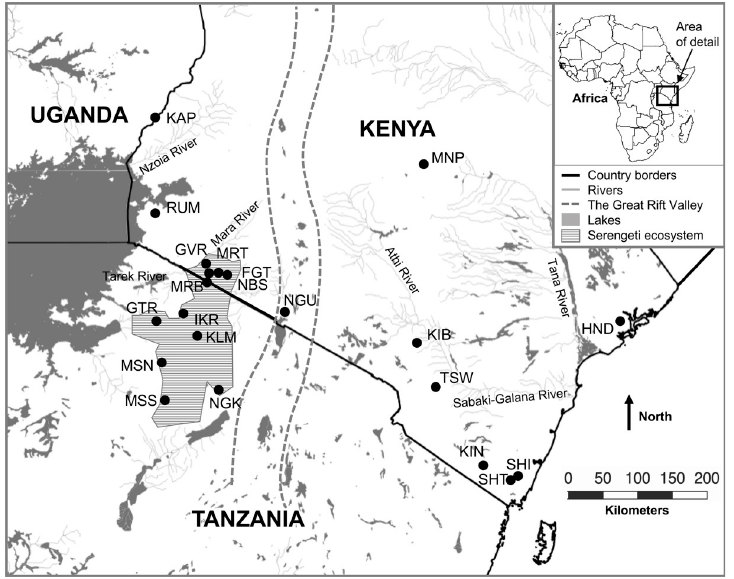
Fig 1. Map showing sample sites in Kenya and Tanzania and location of the study region within Africa. Sampling sites shown with dots and labeled with three letter codes as listed in Table 1. The striped region denotes the 11 sampling sites within the Serengeti ecosystem. The map was created in QGIS v2.12.1 (August 2017; http://qgis.osgeo. org) with free and publicly available data from DIVA-GIS (August 2017;